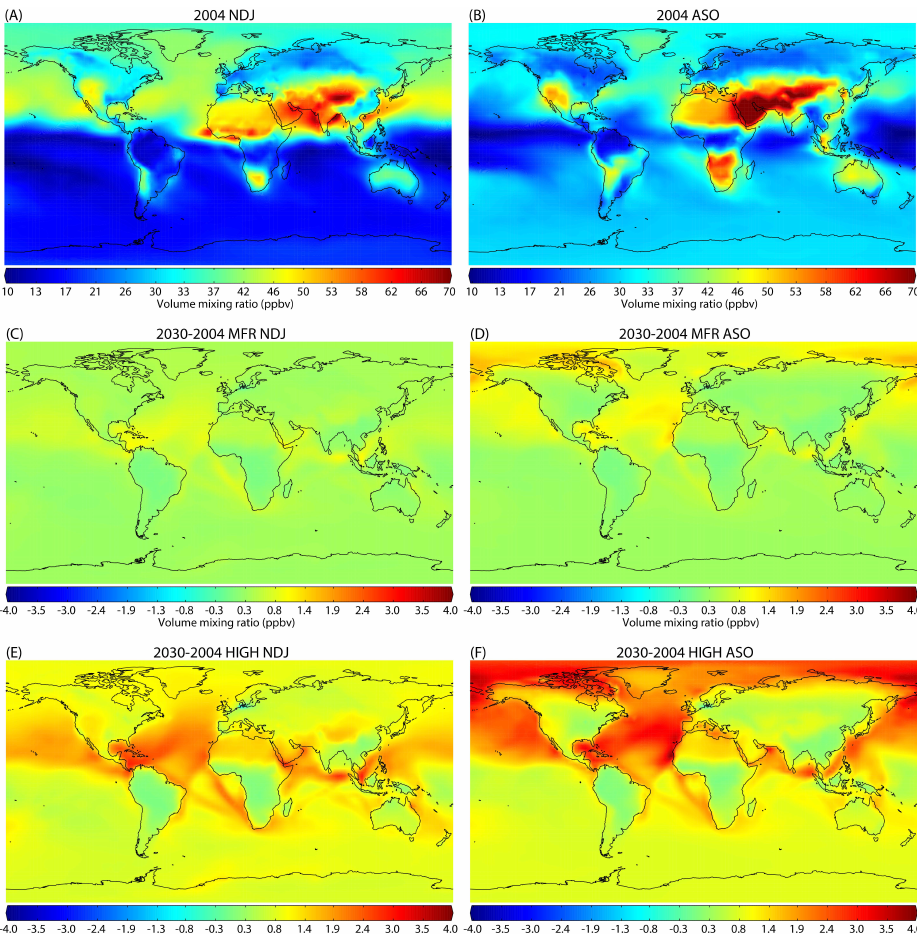
Fig. 2. O 3 in the lowest model layer close to the surface (ppbv). Averages 2004 for the months November-December-January (NDJ) (A) and August-September-October (ASO) (B) . Average change 2004–2030 MFR scenario for the months NDJ (C) and ASO (D) . Average Change 2004–2030 HIGH scenario for the months NDJ (E) and ASO (F)